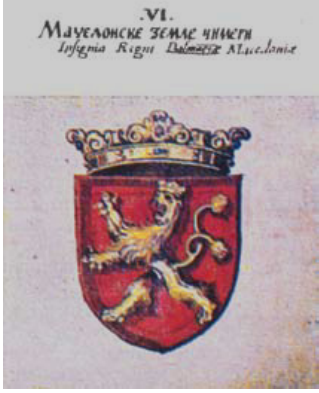
Figure 21. CoA of Macedonia from the Althan armorial.